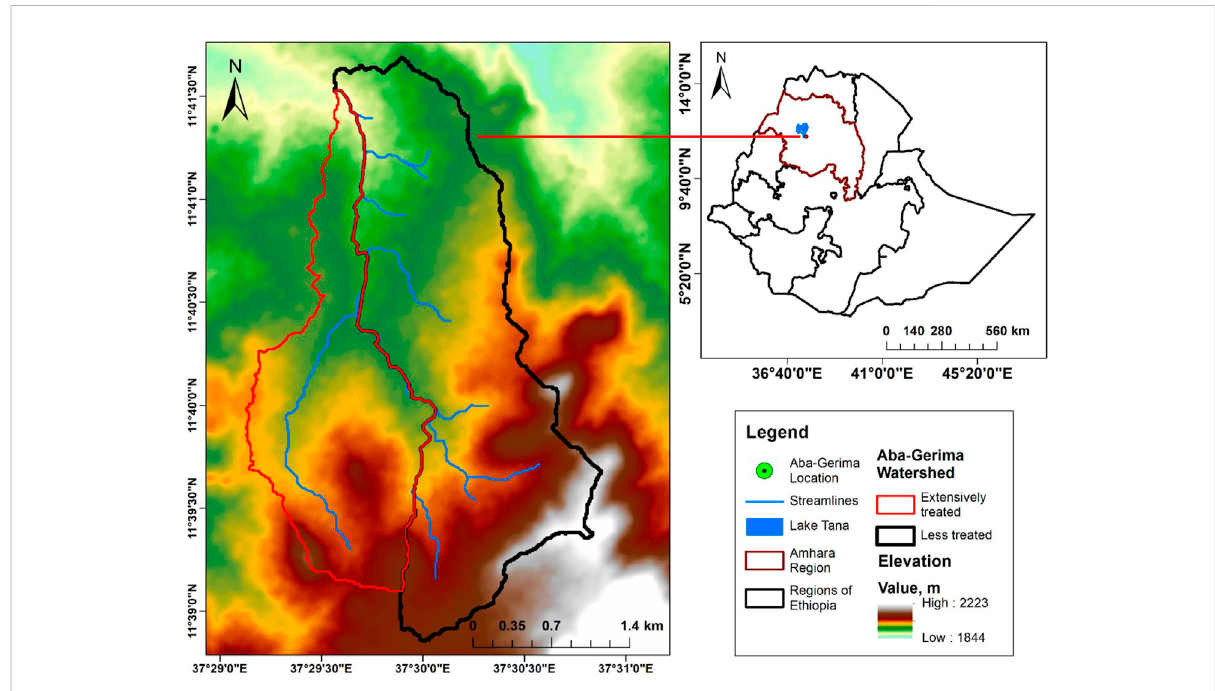
FIGURE 1 Location of the studied watershed showing the treated and less treated